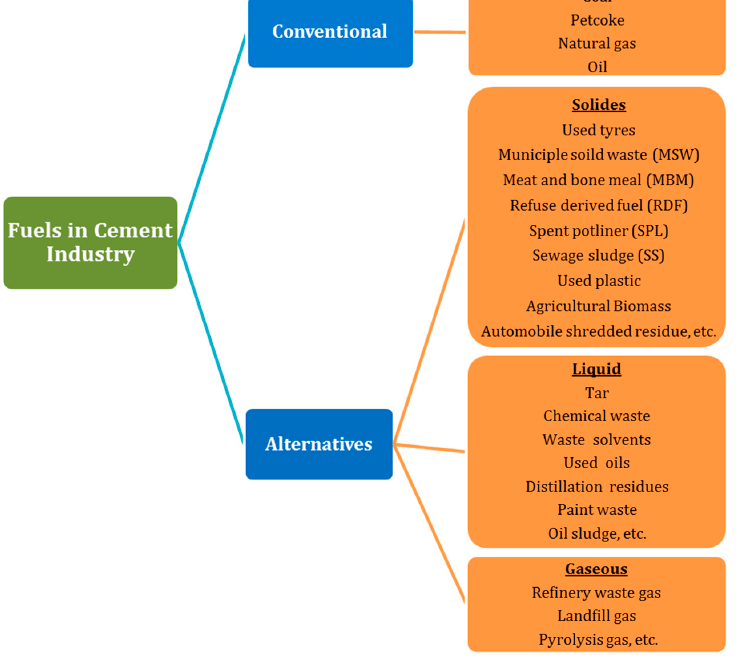
Figure 2. List of fuels (conventional & alternatives) in cement industry.